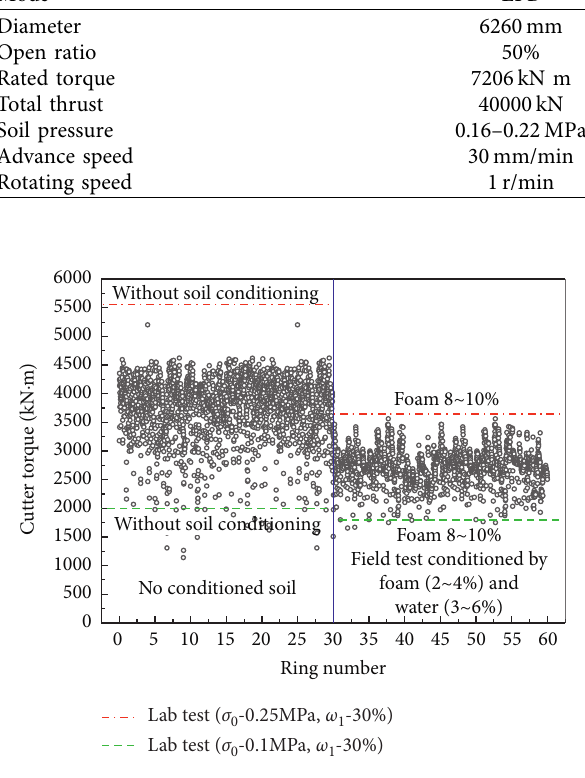
Figure 32: Comparison of laboratory test with field test result.